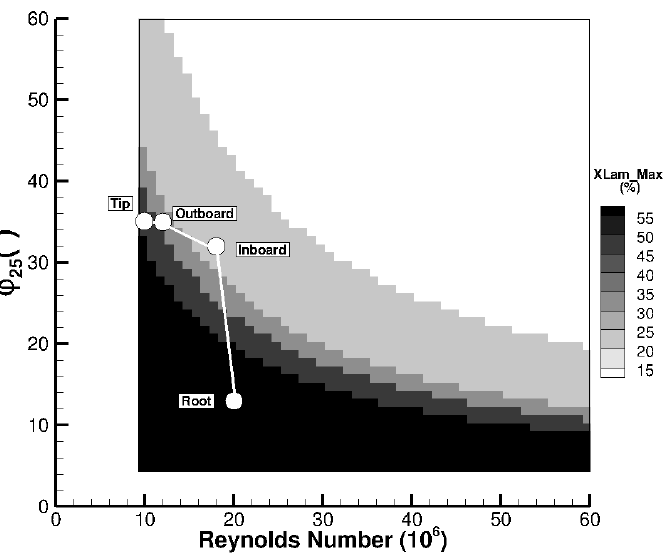
Figure 24. CRM-NLF configuration—estimated maximum transition location by the module (M = 0.8565, Re = 15 × 10 6 , C L = 0.50).